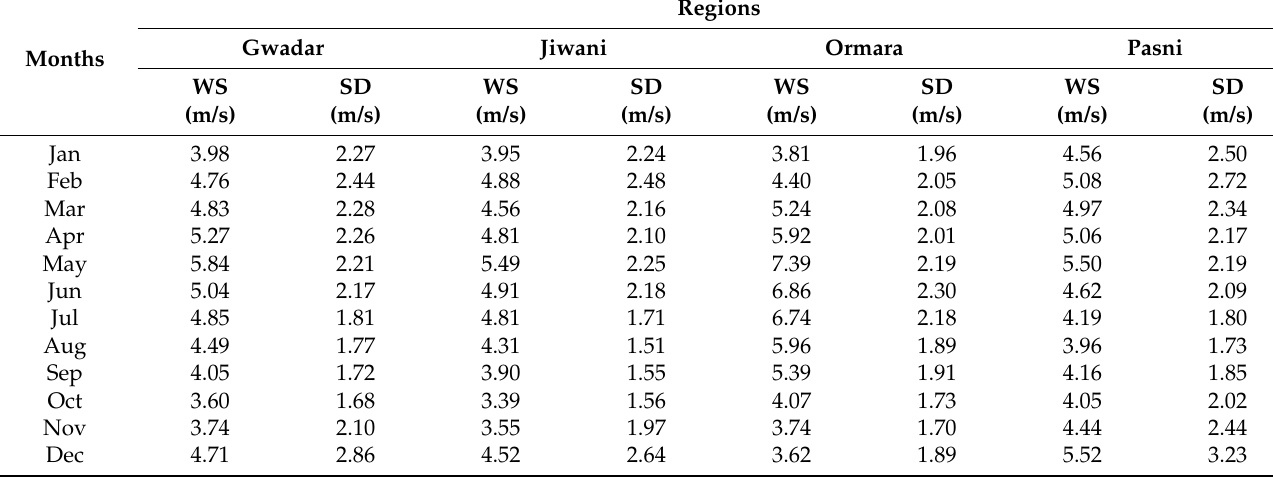
Table 3. Monthly WS and SD for all